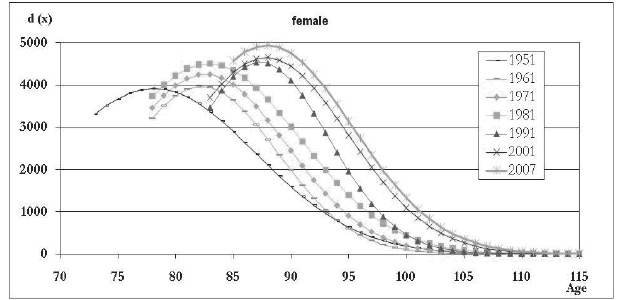
Figure 10 – Female distribution of death fitted with a scaled normal distribution (1951-2007)